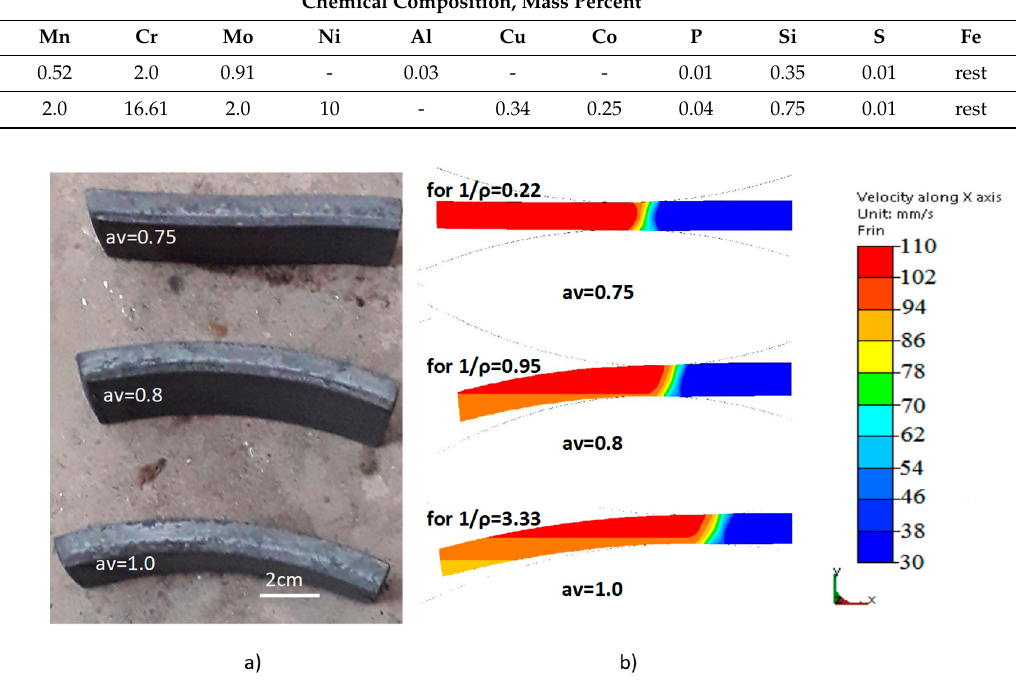
Figure 5. View of samples after asymmetric rolling ( a ) laboratory tests, ( b ) computer simulations.